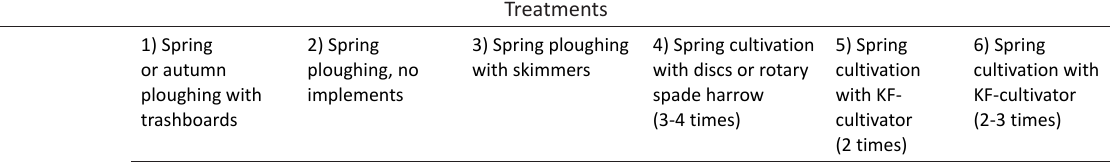
Table 1. Treatments and other farming operations in experiment 1. Treatments were repeated in the same fixed place in 2012 and 2013.